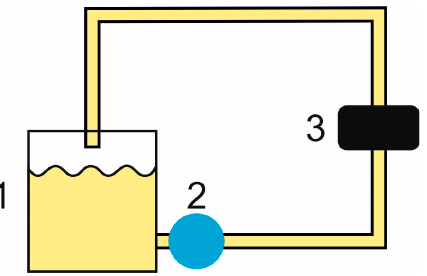
Figure 3. Block diagram of the pumping system used for testing the sensor: (1) milk container; (2) centrifugal pump; (3) laser scatterometric sensor.